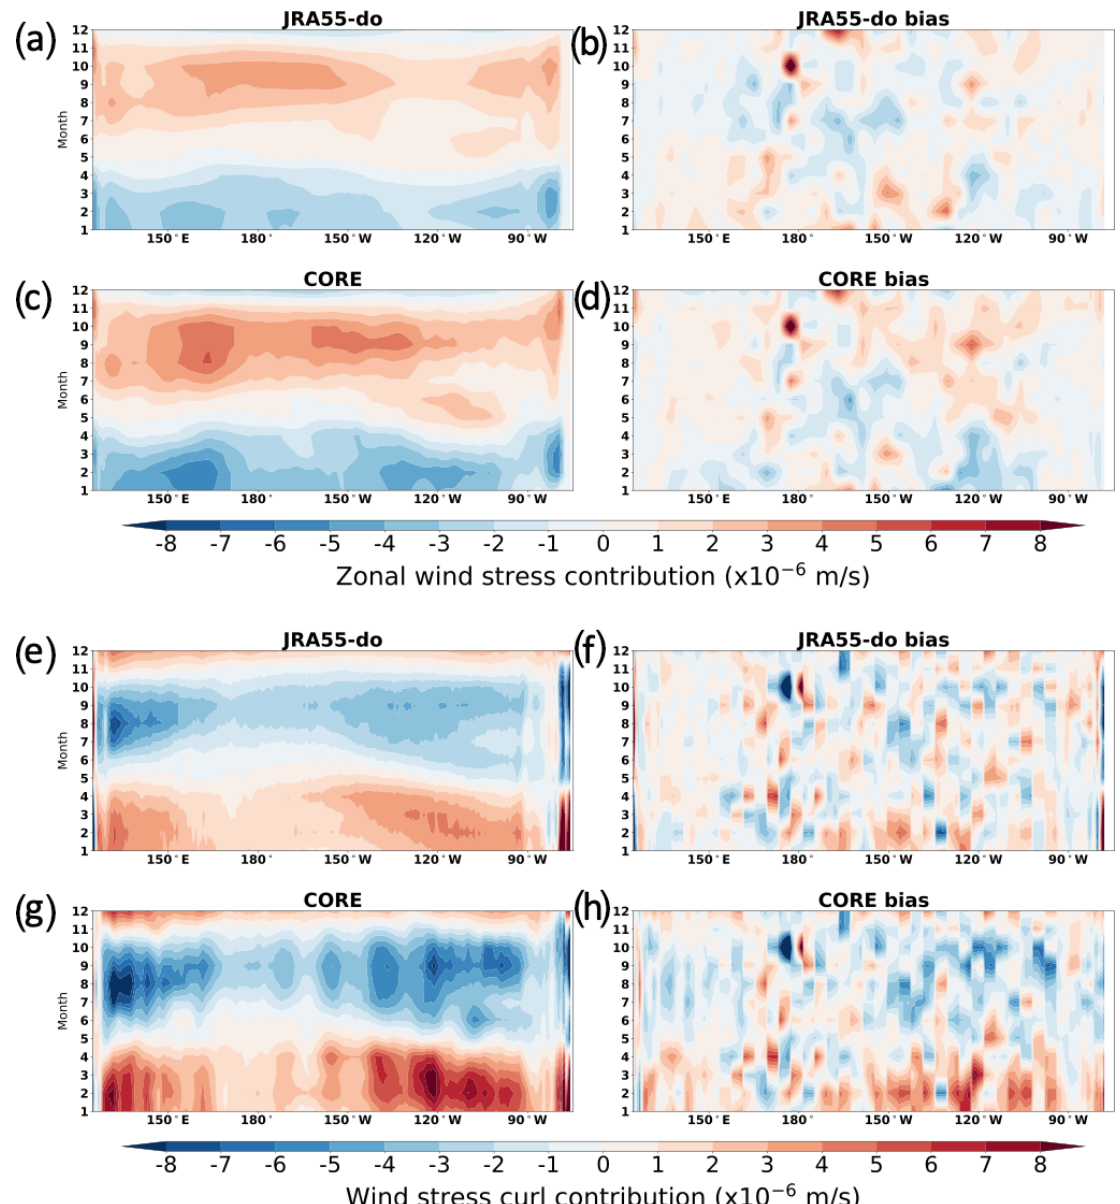
Figure 18. Hovmöller diagram of monthly climatology with mean state removed showing the meridional mean (2 to 10 ◦ N) of (a) zonal- wind-stress-induced Ekman pumping/suction in JRA55-do forcing and (b) the associated bias, (c) zonal-wind-stress-induced Ekman pump- ing/suction in CORE forcing and (d) the associated bias, (e) wind-stress-curl-induced Ekman pumping/suction in JRA55-do forcing and (f) the associated bias, and (g) wind-stress-curl-induced Ekman pumping/suction in CORE forcing and (h) the associated